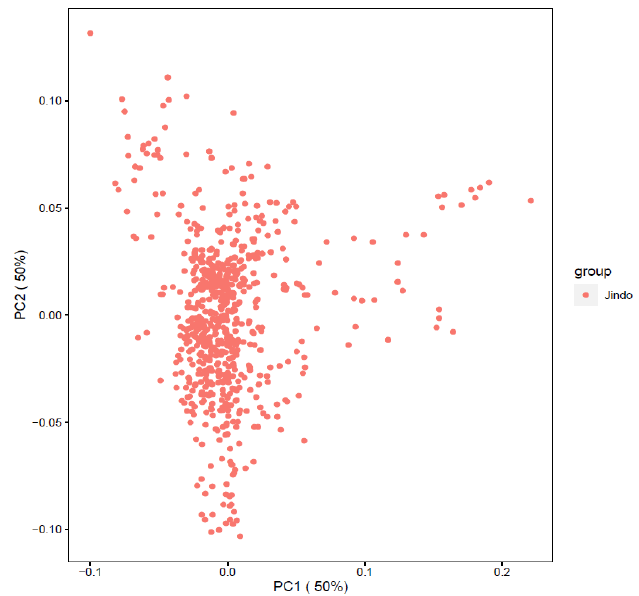
Figure 2. Population structure for all Jindo dog.